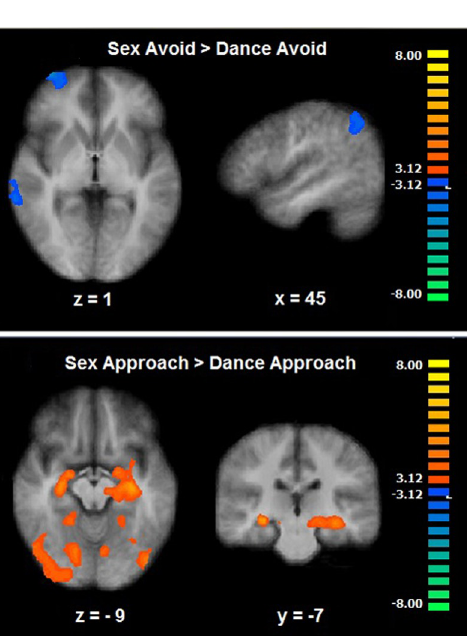
Fig 4. Motivational sexual inhibition—Approach-Avoidance task. Brain activation during the Sex Avoid (up) and Sex Approach trials (down) (CLTC, p <